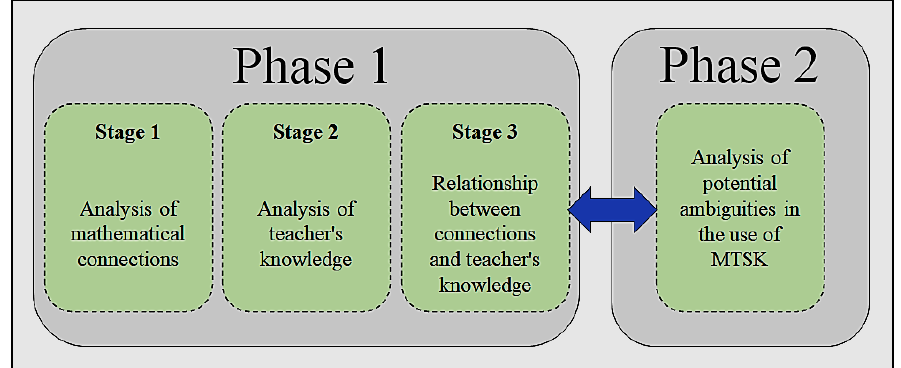
Figure 5. Phases of the analysis process.